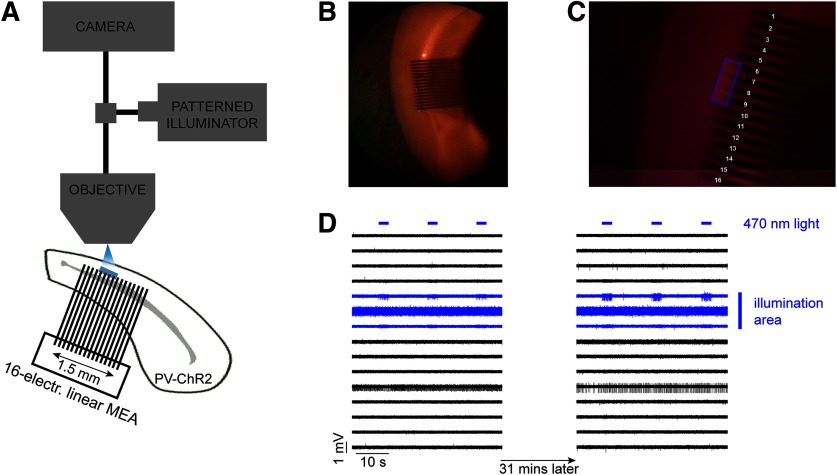
Schematic of the experimental setup and an example of the control experiment. A, Extracellular recordings were taken using a 16-electrode linear MEA placed along layer V in a mouse cortical brain slice in which ChR2 was expressed in PV+ cells. The distance between adjacent electrodes was 100 μm. Photostimulation (blue LED) was delivered using a patterned illuminator through the microscope objective. B, The recordings were taken from the dorsal area of the slice, targeting the primary visual area. C, Example of an illumination pattern (four-electrode-wide area) that was drawn in the middle of the array using the patterned illuminator software. D, A typical control experiment during which repeated illumination was delivered for 31 min while the extracellular K+ remained at normal levels. The evoked activity was only seen at electrodes within the illumination area, and there was no propagating activity, a pattern that remained stable for the entire duration of the recording (31 min).